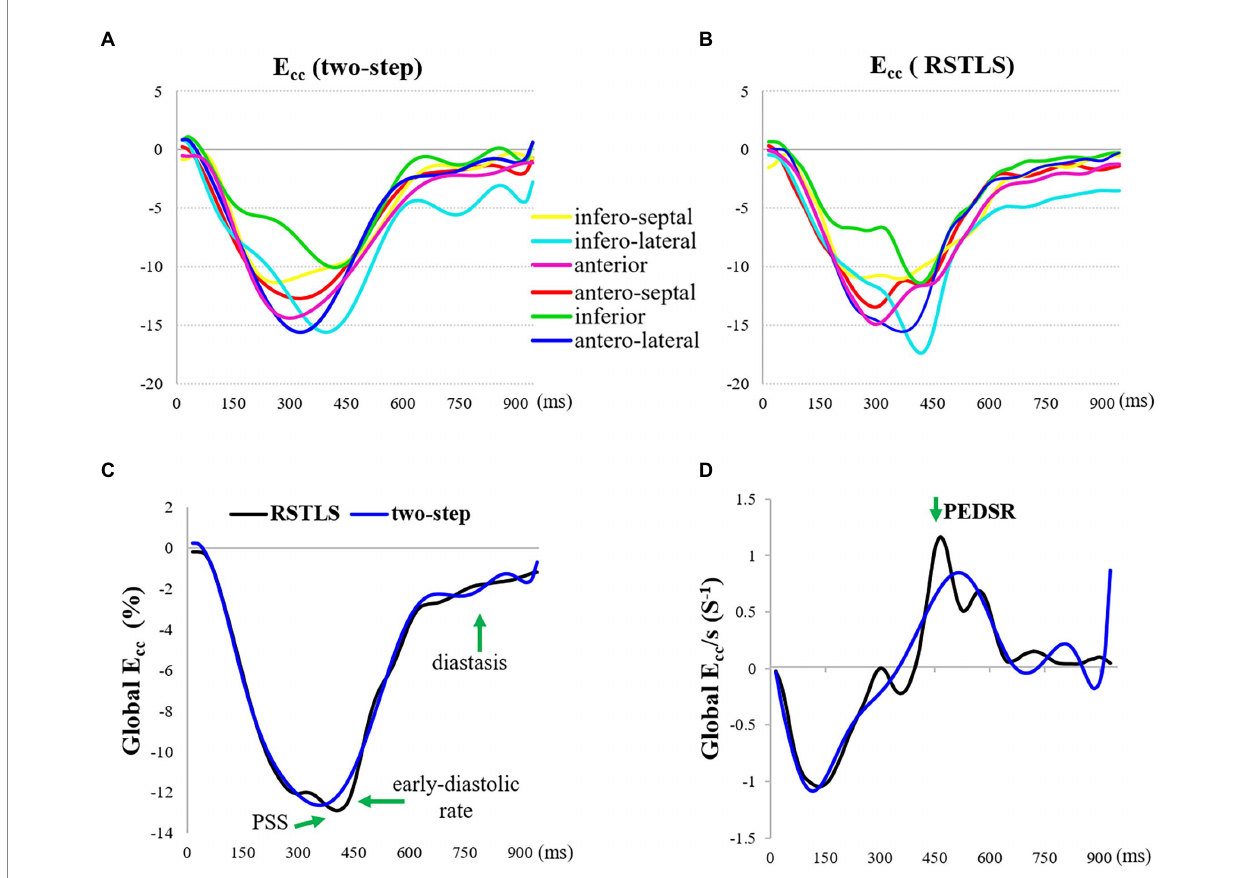
FIGURE 4 An example from a heathy subject comparing circumferential strain (E cc ) curves and strain rate (E cc /s) curves computed using the two-step and RSTLS methods. In both segmental (A, B) and global (C, D) assessments, the RSTLS method better captures features such as post-systolic shortening, early diastole, and diastasis, that are over-smoothed or have oscillation artifacts when computed using the two-step method. PSS = post-systolic shortening, and PEDSR = peak early diastolic strain rate.